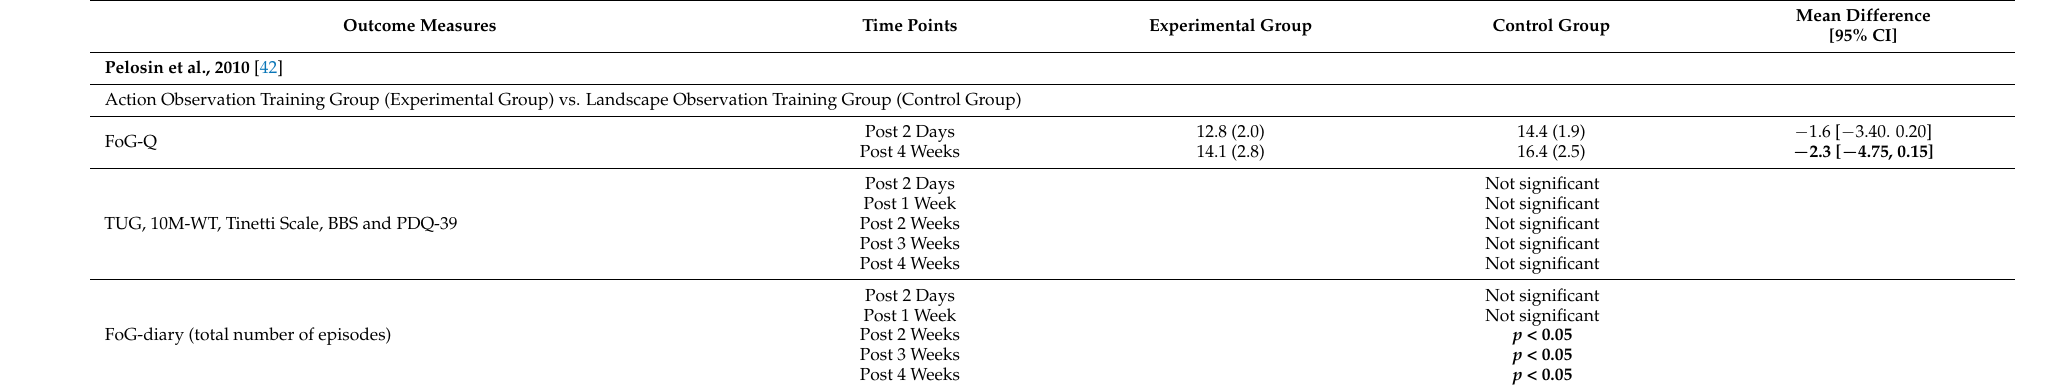
Table 3. Results of included